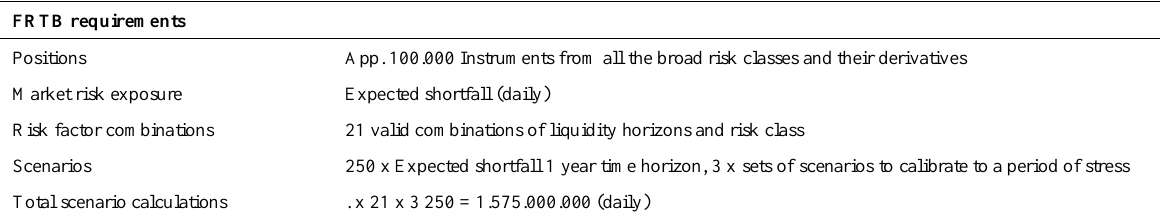
Table 5. FRTB requirements